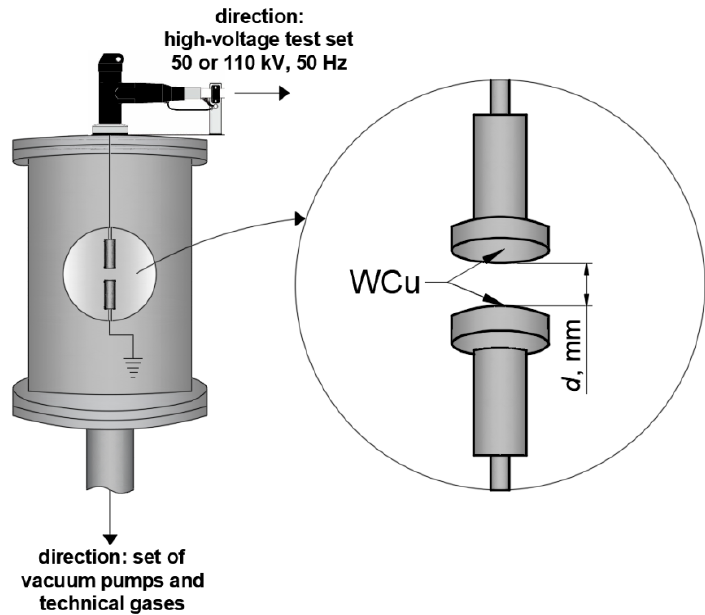
Figure 4. The main component of the lab bench—a discharge chamber with a contact system.